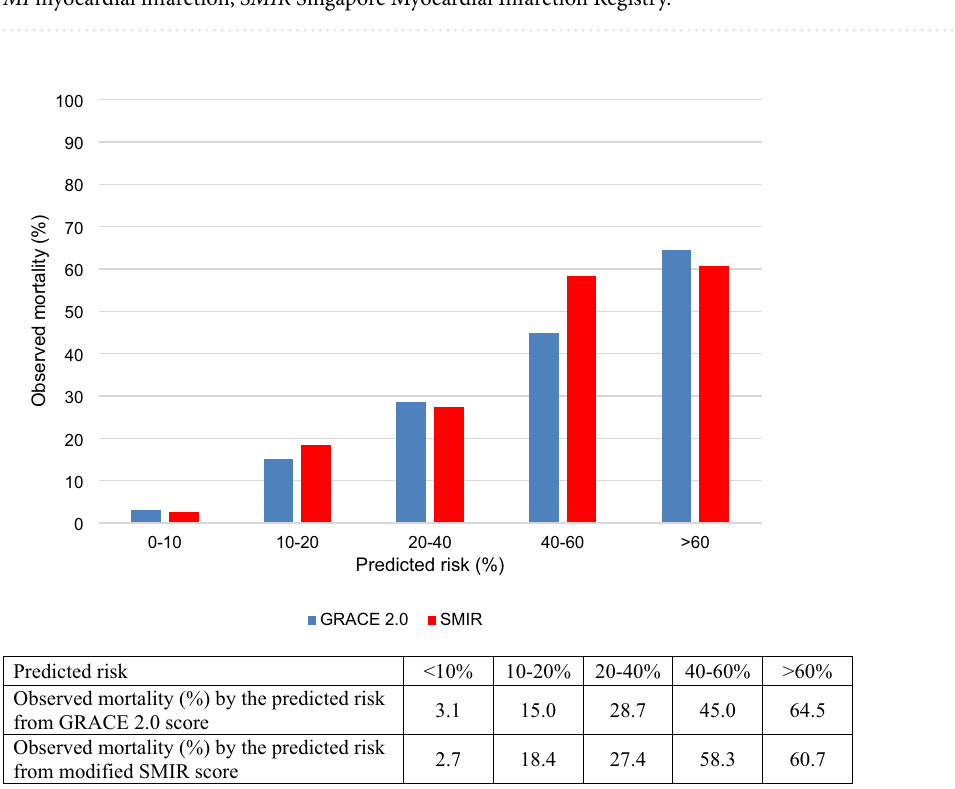
Figure 1. Observed 1-year all-cause mortality and predicted risk from the GRACE 2.0 and modified SMIR scores. The predicted mortality from the GRACE 2.0 (blue) and modified SMIR (red) scores were compared with the actual 1-year all-cause mortality observed among the AMI patients in SMIR. GRACE Global Registry of Acute Coronary Events, SMIR Singapore Myocardial Infarction